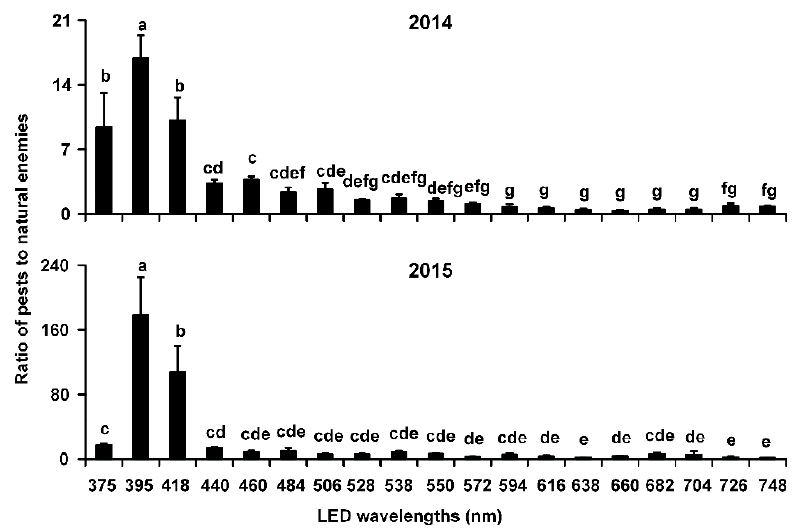
Figure 5. Ratios of pests to natural enemies trapped in LED-equipped traps with 19 single wavelengths during 2014–2015. Individual bars represent the mean (±SE) ratio of pests to natural enemies, with accompanying letters denoting statistically significant differences among the LED wavelengths in a given year (ANOVA, p < 0.05). Table 2. Statistical values from the average abundance analyses of pests and natural enemies in different taxonomic groups trapped in LED traps with 19 single wavelengths during 2014–2015.